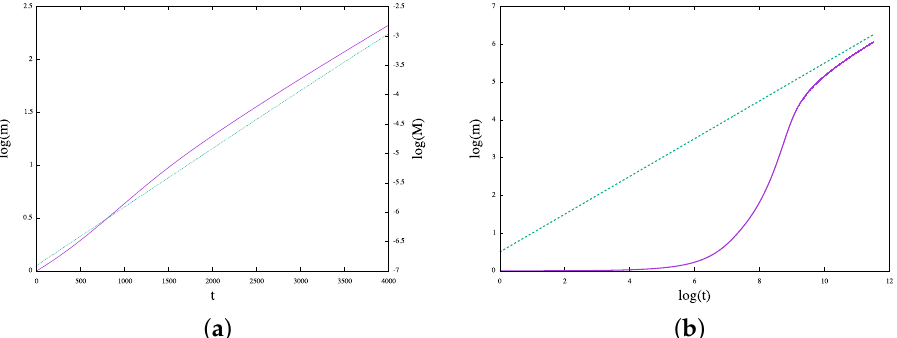
Figure 13. ( a ) Log–log plot of the maximum height of corpus (approximating the corpus site) m ( t ) versus time t for early times. ( b ) The log–log plot of m ( t ) versus t . The dotted line marks the exponent